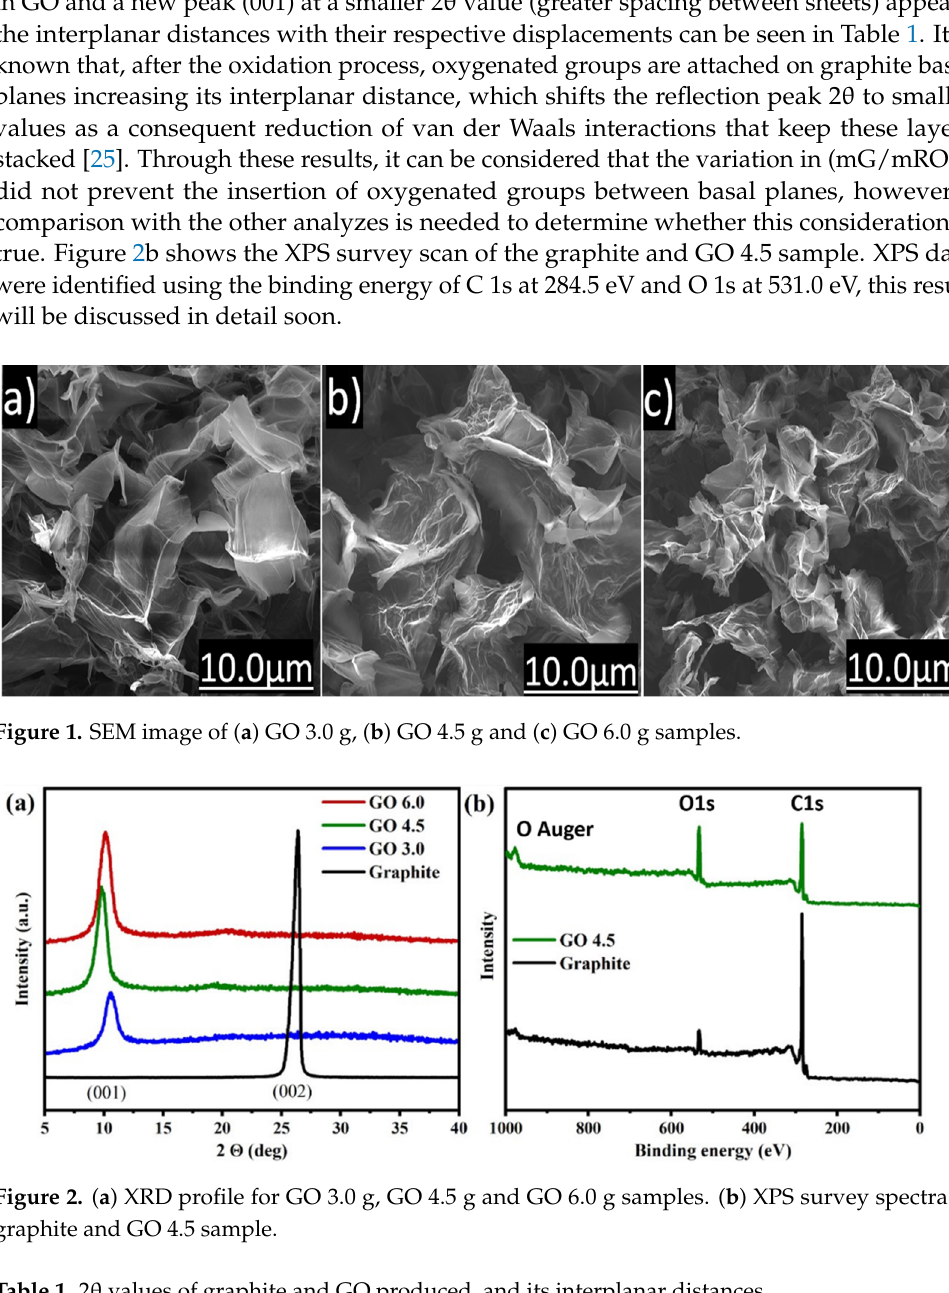
Figure 1. SEM image of ( a ) GO 3.0 g, ( b ) GO 4.5 g and ( c ) GO 6.0 g samples.